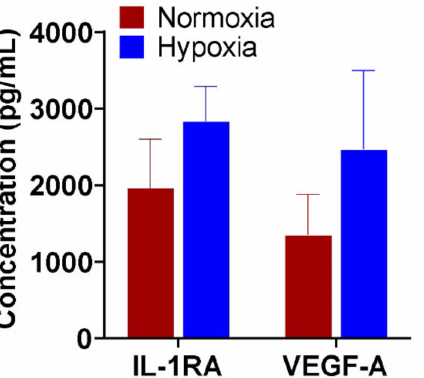
Figure 1. Hypoxia preconditioning enhances bioactive factors. Levels of IL1RA and VEGF-A were measured in placental membranes, amnion and chorion, and umbilical tissue in normoxia and after hypoxia conditioning. N = 3